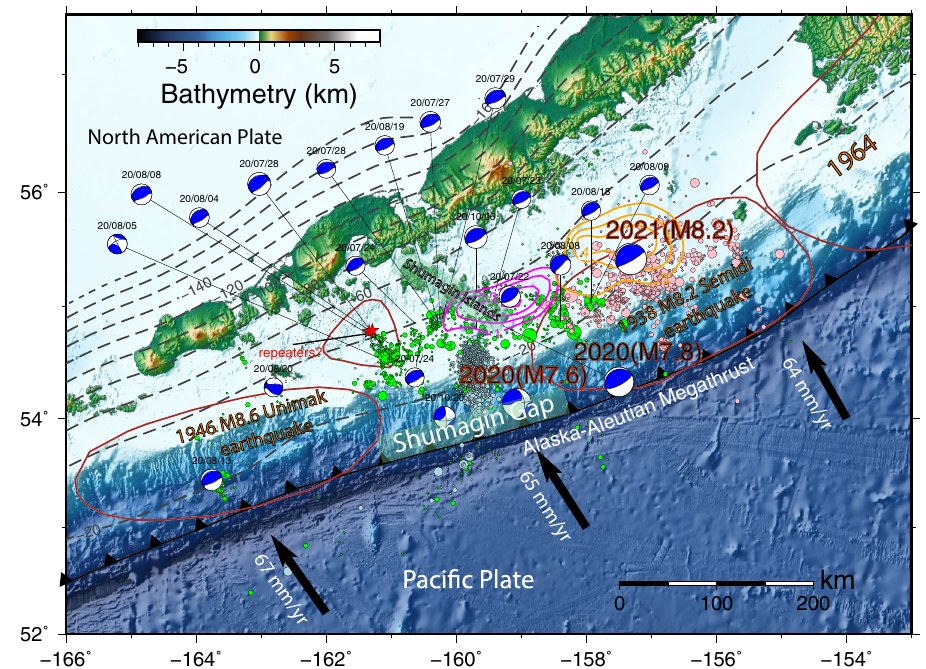
Fig. 1 Seismotectonic setting of the Alaska-Aleutian megathrust. The coseismic slip pattern for the 2020 Simeonof (Fig. 2) and 2021 Chignik earthquakes from U. S. Geological Survey (USGS) (https://earthquake.usgs.gov/earthquakes/eventpage/ak0219neiszm/ fi nite-fault, last accessed August 22, 2021) are outlined in magenta and orange contours, respectively. The beach balls show focal mechanisms for M ≥ 5 earthquakes from the Global Centroid Moment Tensor catalog (GCMT) since the occurrence of the 2020 Simeonof mainshock. Aftershocks of the 2020 Simeonof earthquake until the 2020 Mw 7.6 Sand Point earthquake, 30-day aftershocks after the Sand Point event, and 20-day aftershocks following the 2021 earthquake from the USGS are shown with green, light blue, and pink circles, respectively, with size scaled by earthquake magnitude. Two red stars are similar earthquakes detected by Igarashi & Kato 62 that occurred in 1995 and 2011 and may indicate fault creep. Dashed black lines depict the depth contours from the Slab2 model 65 . Dark red curves delineate the approximate rupture areas of the three great historical earthquakes based on the distribution of aftershocks. Black vectors show the Paci fi c Plate velocities with respect to the North American Plate 74